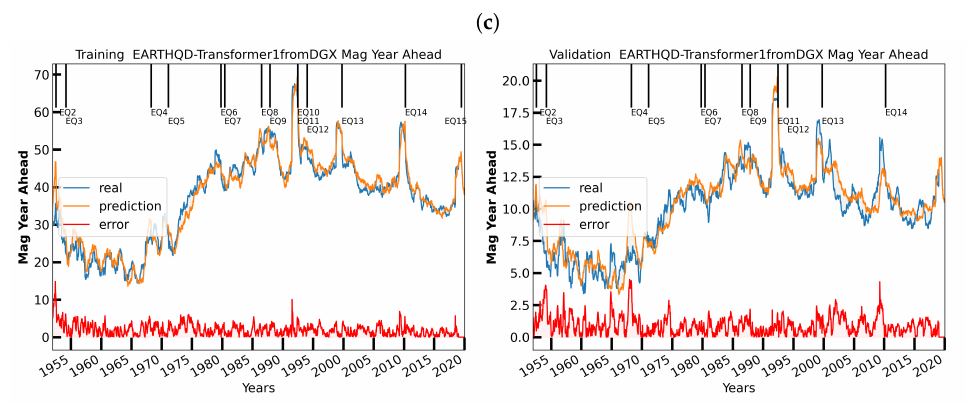
Figure 17. One-year m bin ( F : ∆ t , t ) results for ∆ t = 52 weeks (training on left, validation on the right) are given for 3 methods. The earthquakes marked are listed in Table 1. ( a ) One-year LSTM results for m bin ( F : ∆ t , t ) for ∆ t = 52 weeks. ( b ) One-year TFT results for m bin ( F : ∆ t , t ) for ∆ t = 52 weeks. Note TFT results are formed using m bin ( F : ∆ t , t ) = m bin ( B : ∆ t , t + ∆ t ) . ( c ) One-year science transformer results for m bin ( F : ∆ t , t ) for ∆ t = 52 weeks.